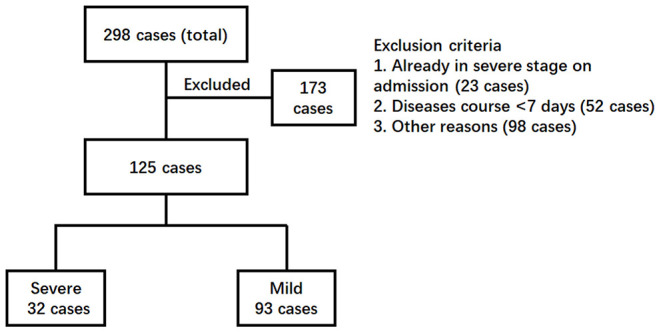
Enrollment chart of COVID-19 patients. The clinical information of a total of 298 patients admitted to the hospital was reviewed. Patients were excluded according to the criteria (1) already in severe stages, (2) with a disease course <7 days, and (3) other reasons such as incomplete detection panel. Finally, 125 patients were further divided into two groups. The severe group included the patients who developed severe COVID-19 pneumonia later (>3 days post-admission). The patients remaining were kept in the mild group.